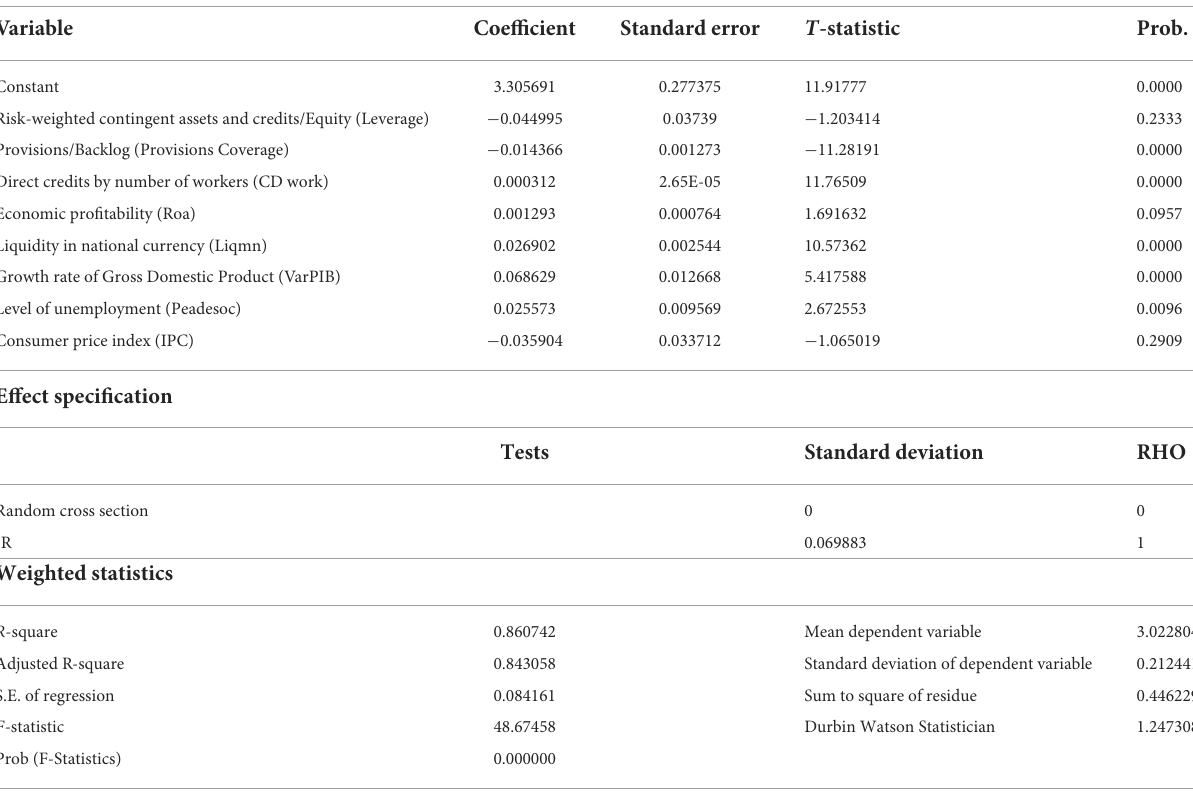
TABLE 1 Determinants of delinquency in